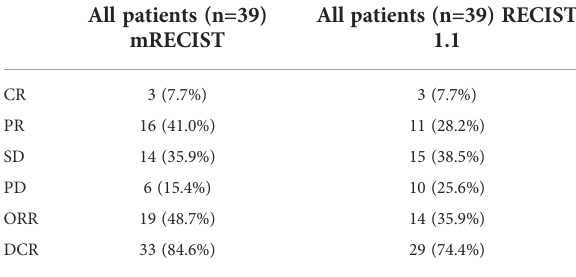
TABLE 7 Summary of the best tumor response. All patients (n=39) All patients (n=39) RECIST mRECIST